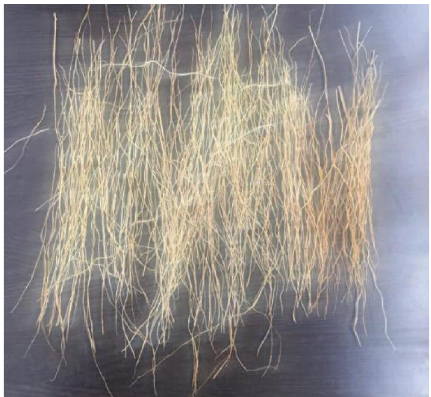
Figure 2: Extracted inforescence